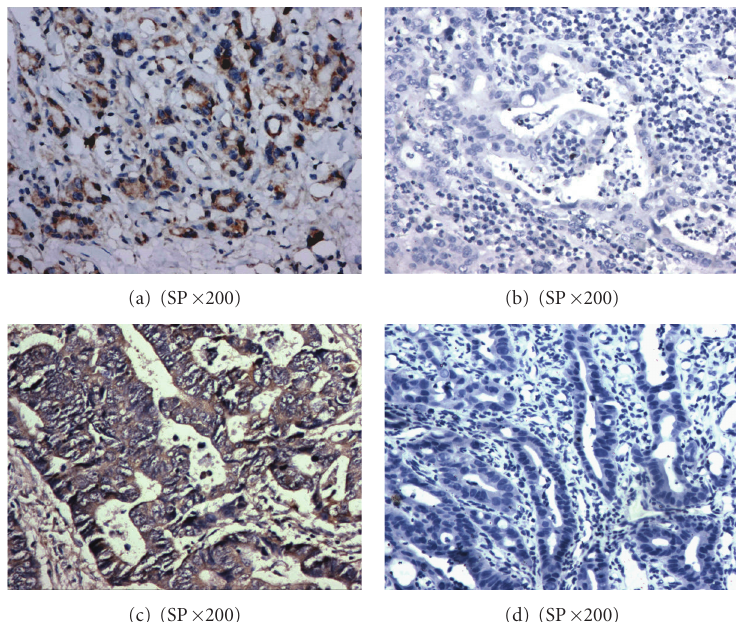
Figure 2: Protein expression of TSP1 and TGF- β 1 in GCA tissues. (a) Positive staining of TSP1, (b) negative staining of TSP1, (c) positive staining of TGF- β 1, (d) negative staining of TGF- β 1 .